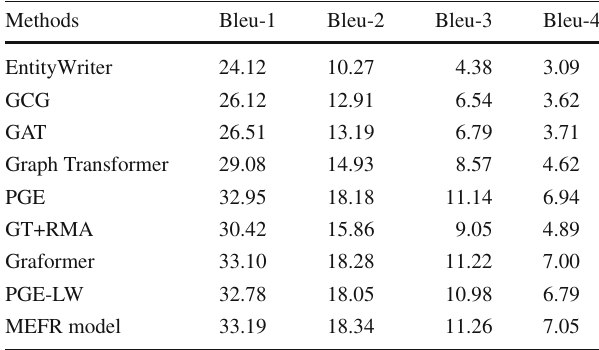
Table 3 Results of different generation models on AGENDA test set